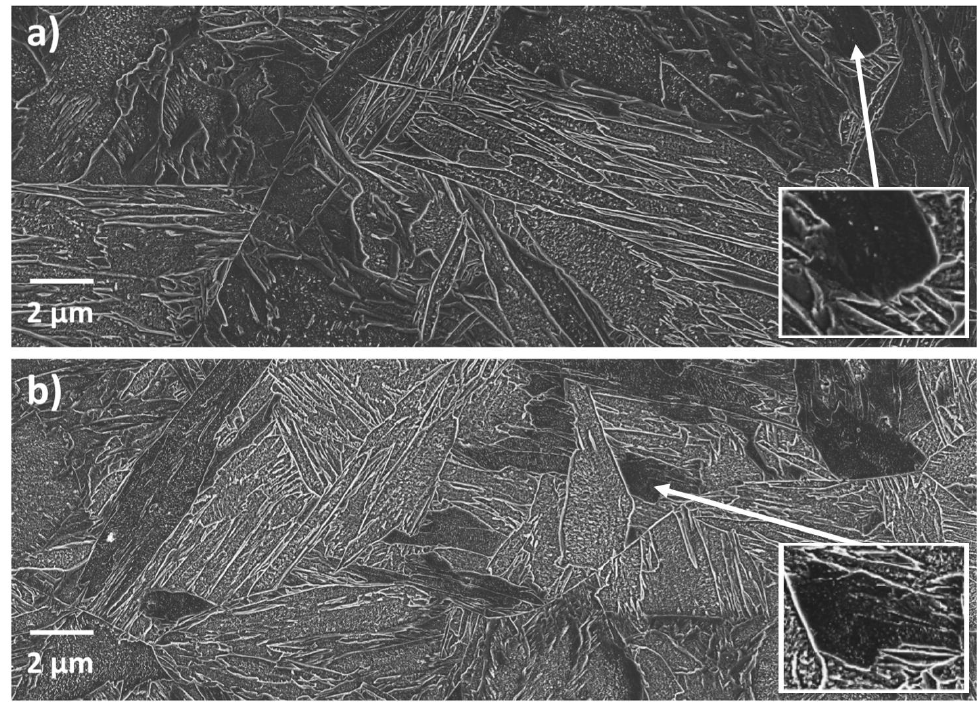
Figure 2. Scanning Electron Microscopy (SEM) secondary electron micrographs of specimens austenitized and quenched in the Gleeble: ( a ) cold-mounted ( b ) hot-mounted. Insets are magnified images of areas showing the least auto-tempering. Both images were obtained from the centers of transverse cross sections through the specimens.